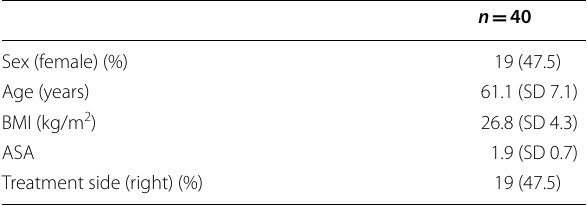
Table 1 Study group